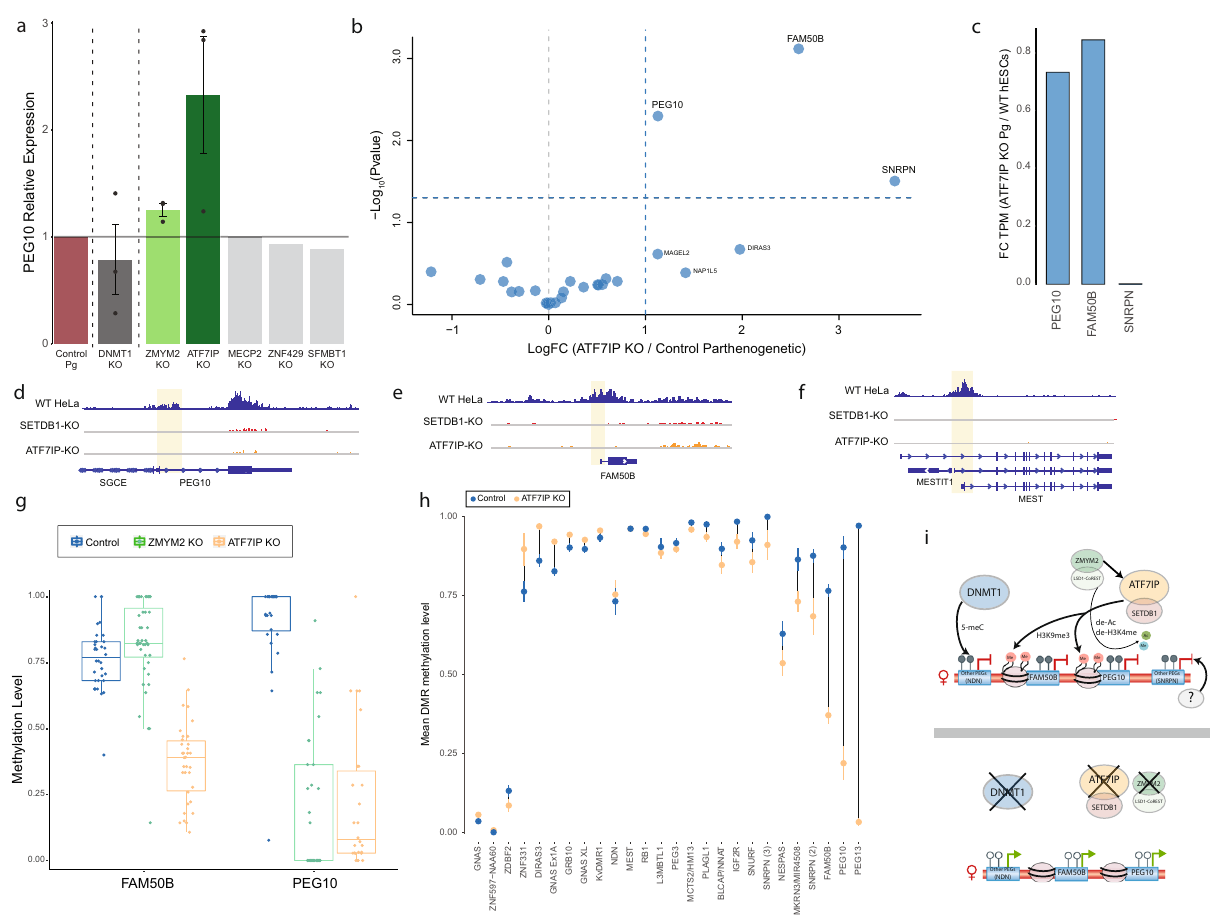
Fig. 3 ATF7IP is required to maintain a set of maternally imprinted loci. a Bar plot of PEG10 expression relative to control, in hpESCs cells infected with sgRNAs targeting DNMT1 and 5 candidate genes. n = 3 independent experiments for DNMT1, ATF7IP, ZMYM2, and control samples. Data are presented as mean ± SEM. b Volcano plot of differential expression (calculated by edgeR) showing the log 2 fold change (FC) between ATF7IP KO and control (empty Cas9 vector) hpESCs for all PEGs ( x axis). n = 3 replicates from each cell type. y Axis represents − log 10 P value. c Bar plot showing the FC of the mean TPM in ATF7IP KO hpESCs ( n = 3) relative to the mean TPM in bi-parental hESCs ( n = 4). d – f Integrated Genomics Viewer (IGV) visualization of H3K9me3-ChIP-Seq peaks in WT, SETDB1 KO, and ATF7IP KO HeLa cells at the PEG10 locus ( d ), FAM50B ( e ), and MEST ( f ). The location of the imprinted DMR is highlighted in yellow. g Boxplots displaying the median with 25th – 75th percentile and range of methylation levels ( β values) of individual CpGs within the DMRs of PEG10 and FAM50B in control hpESCs (blue), ZMYM2 KO (green), or ATF7IP KO (orange) hpESCs. Dots represent individual CpGs. Whiskers represent values within 1.5 times the interquartile range. h Mean methylation levels ( β values) of imprinted DMRs in control (blue) or ATF7IP KO (orange) hpESCs. Data are presented as mean ± SEM. Lines are drawn between dots to represent the difference in mean methylation levels. i An illustration summarizing our model for imprinting regulation in hESCs. Maternal imprinting in hESCs is maintained by various factors in a locus-speci fi c manner. Several PEGs (e.g., NDN) are directly regulated by DNA methylation and their imprinting depends on DNMT1 expression. ATF7IP preserves imprinting of PEG10 and FAM50B via the repressive histone modi fi cation H3k9me3. ZMYM2 KO is also suf fi cient for an apparent loss-of-imprinting of PEG10 , possibly via its direct interaction with ATF7IP or/and excessive acetylation following its deletion. The repression of other PEGs (e.g., SNRPN ) in hpESCs is either redundant with, or maintained by factors, which are yet